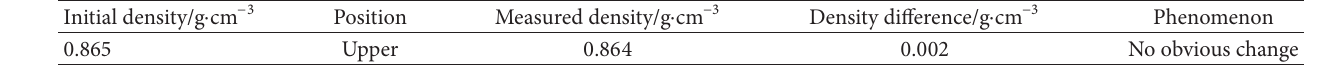
Table 4: The evaluation of sedimentation stability (method of using measuring cylinder).